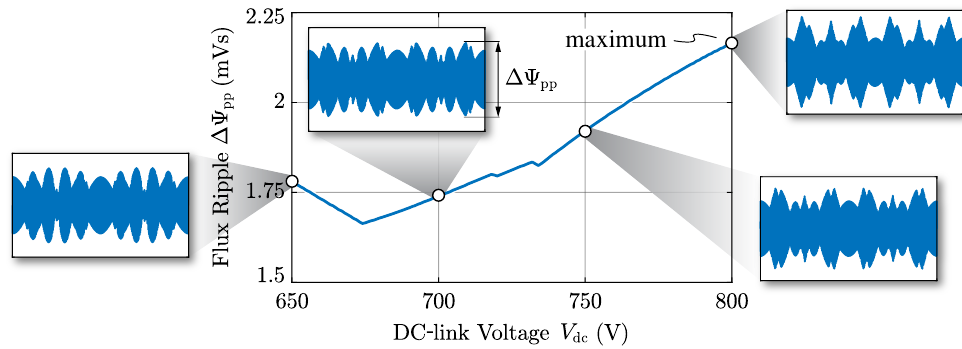
Figure 8. Peak-to-peak grid-side inductor flux ripple ∆Ψ pp considering zero mid-point current modulation and variable DC-link voltage V dc . A highlight of the time-domain waveforms is